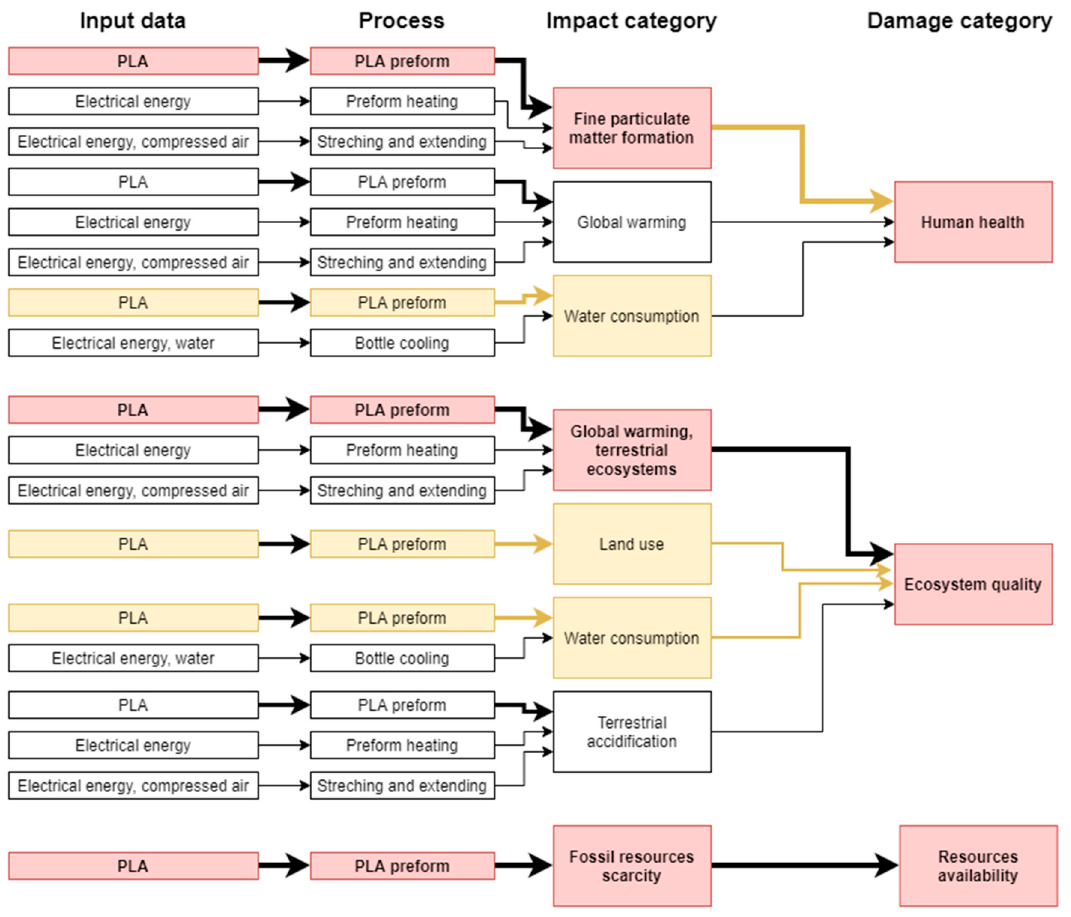
Figure 22. Paths of key links between input data and impact and damage categories. The figure presents input data for only significant stages of the PLA bottle shaping process and relevant impact categories. Bold arrows represent inputs with the greatest share in the process or category. Chains marked in red are those with the greatest share in the damage category, while yellow chains bring the greatest uncertainty with respect to the final result of the impact and damage category.